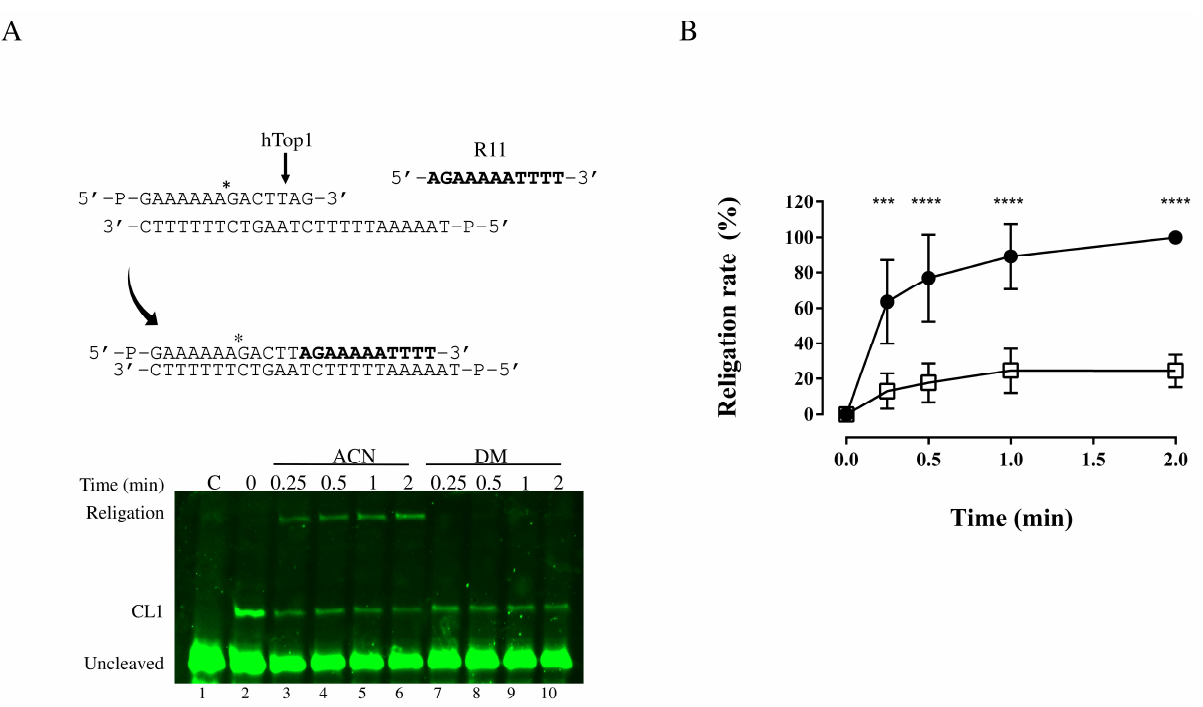
Figure 4. Analysis of the religation of the hTop1 catalytic mechanism on the fluorescently labeled SS. ( A ) Top panel reported the sequences of the fluorescently labeled SS for the religation assay. Bottom panel is a denaturing polyacrylamide gel of the religation assay. Samples were incubated 1 h at 25 ◦ C and then 30 min at 37 ◦ C. Reaction started by adding a 200-fold excess of R11 oligonucleotide in the absence and presence of 100 µ M of DM, and then stopped at different time points with 2.5% SDS. CL1 is the cleaved strand, C is the negative control and 0 is the starting condition before adding R11. ( B ) Plot of the religation assay where the percentage of the appearance of the religated bands as function of time is reported. Black circles and white squares represent DM and can, respectively. The figure shows the cumulative data, with mean ± SD values, of three different experiments. Asterisks indicate * p ≤ 0.05, *** p ≤ 0.001 and **** p ≤ 0.0001.